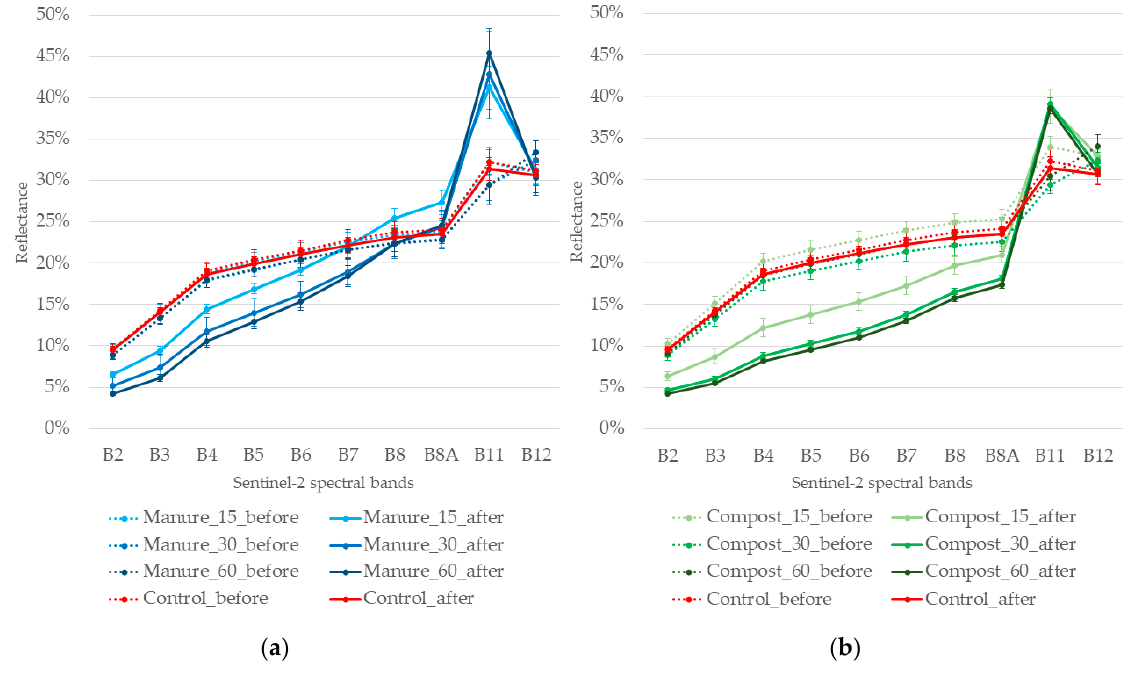
Figure 6. Simulated Sentinel-2 reflectance spectra of the day 0 before amendment spreading (dotted line) and the day 2 after amendment spreading (full line) in surface according to EOM quantity ( a ) for green waste compost; ( b ) for sheep manure.